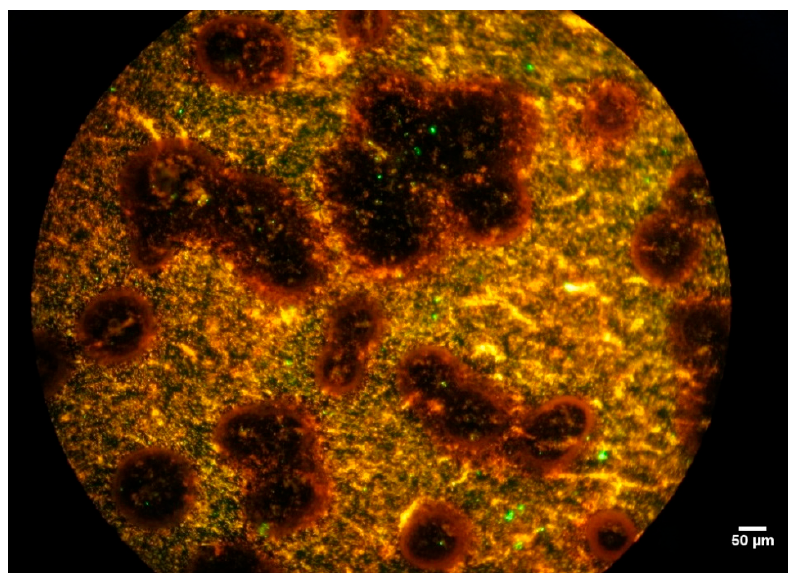
Figure 10. Micrograph of metal coupon (S9) after 7 days of exposure (before cleaning). A biofilm was detected on the metal coupon surface. Active cells (green) were mostly found in the pits whereas red (inactive) cells were located around the pits.